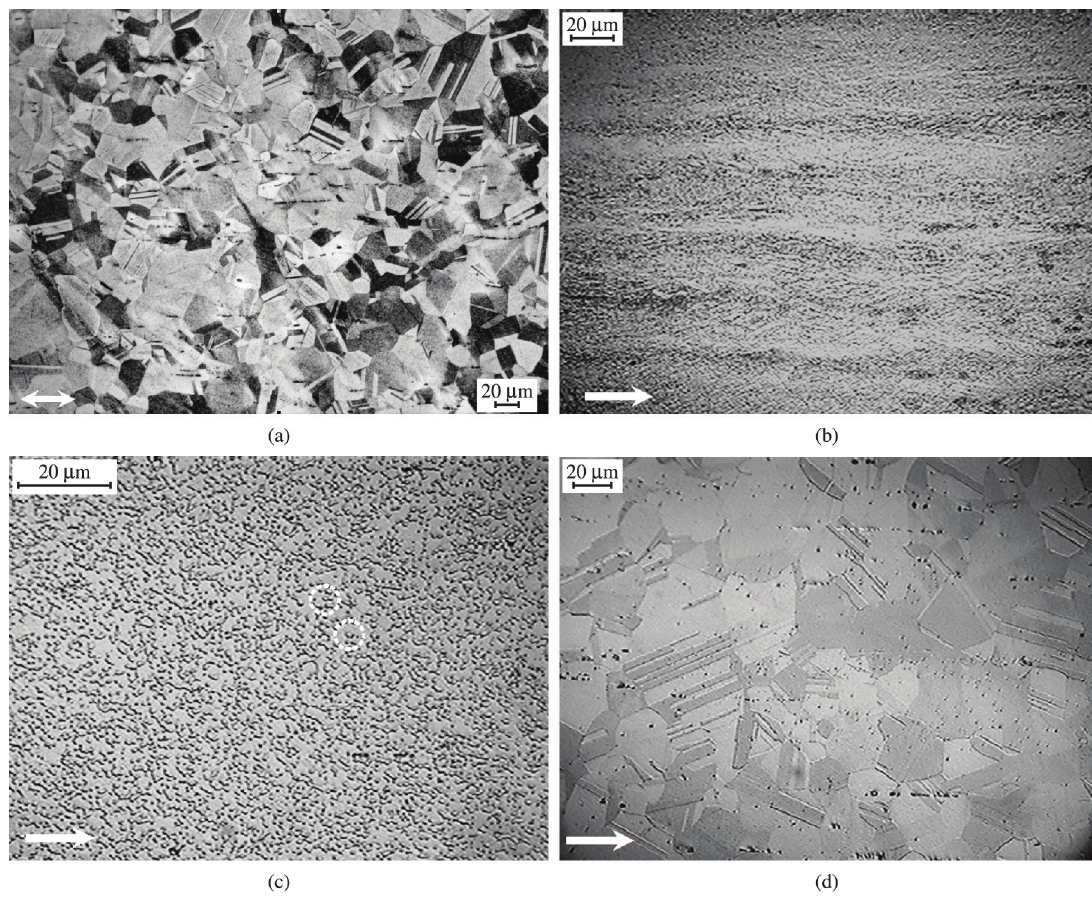
Figure 2. The optical micrographs of specimens in different conditions: (a) solution treated, and deformed and annealed at (b) 750°C for 1h, (c) 850°C for 1h and (d) 950°C for